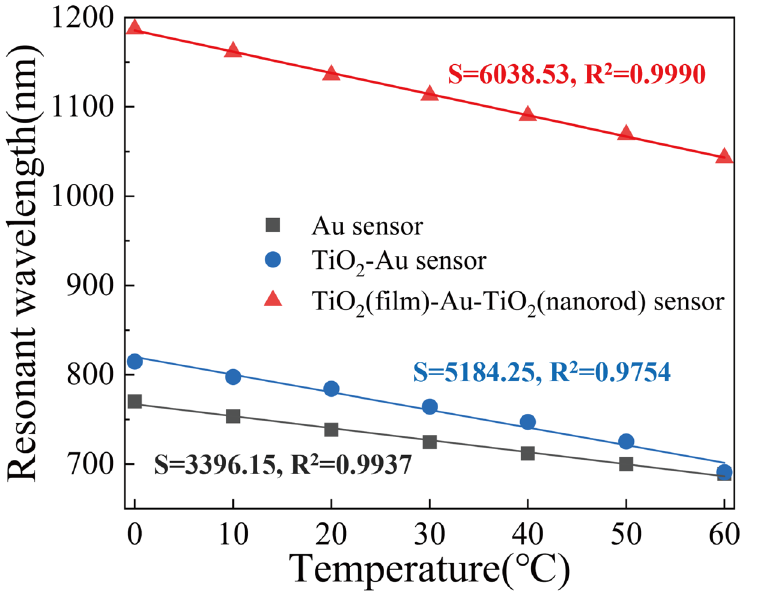
Figure 9. SPR wavelengths corresponding to temperature of three proposed SPR temperature sen- sors and linear fitting curves. and linear fitting